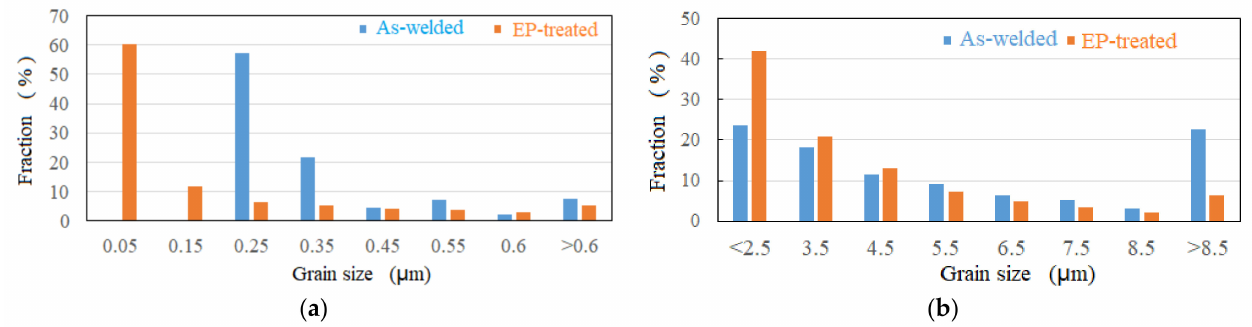
Figure 5. Grain size distributions: ( a ) FCC; ( b )